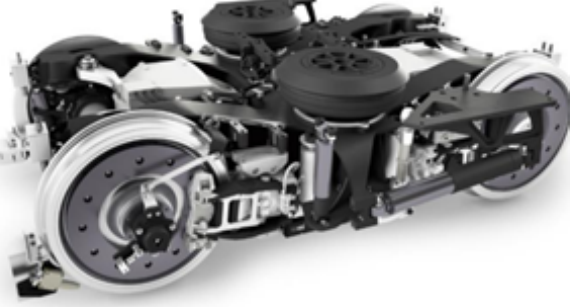
Figure 5. Bogie SIEMENS SF 7500 with inner frame and inside bearings – train unit MIREO [3].